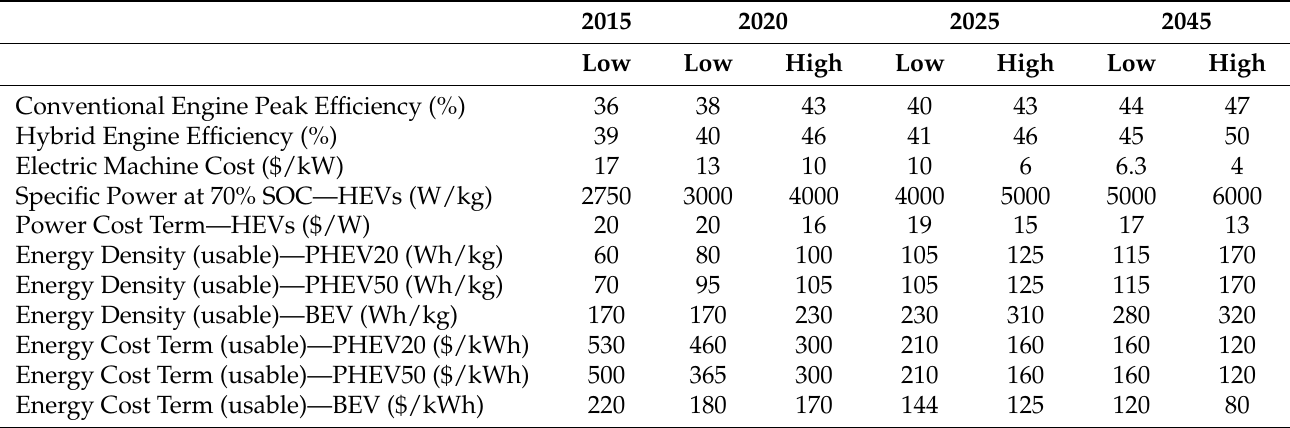
Table 2. Technology